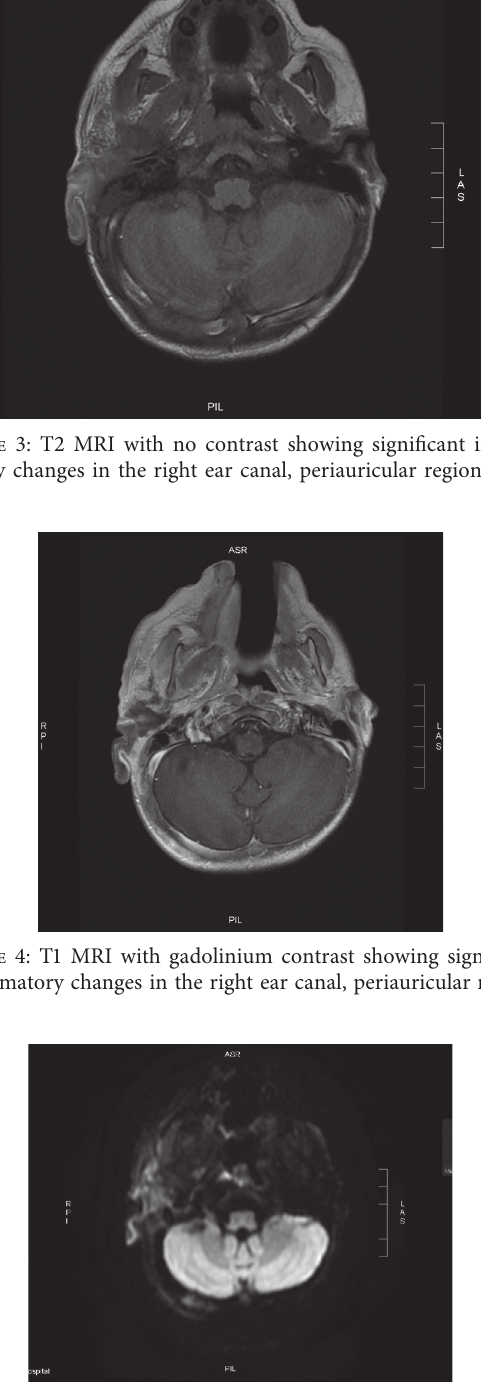
Figure 5: Diffusion-weighted imaging showing significant in- flammatory changes in the right ear canal, periauricular region.